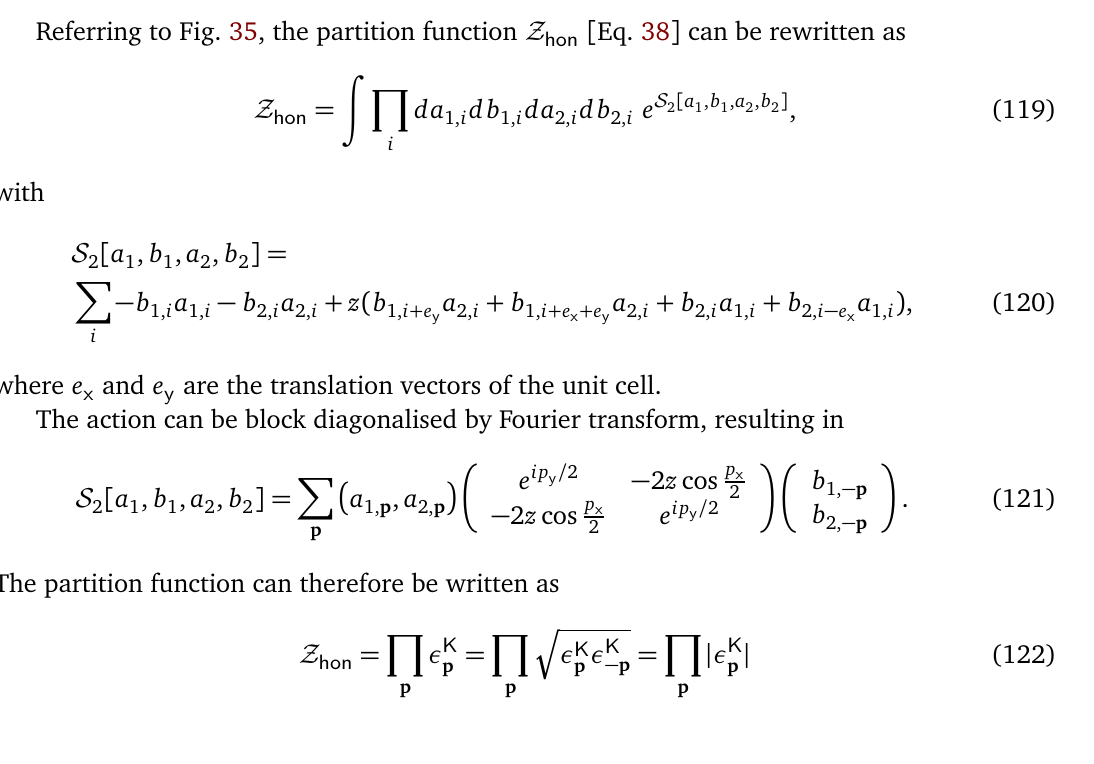
[ Eq. 32 ] ABB , b , a and b 1 1 2 2